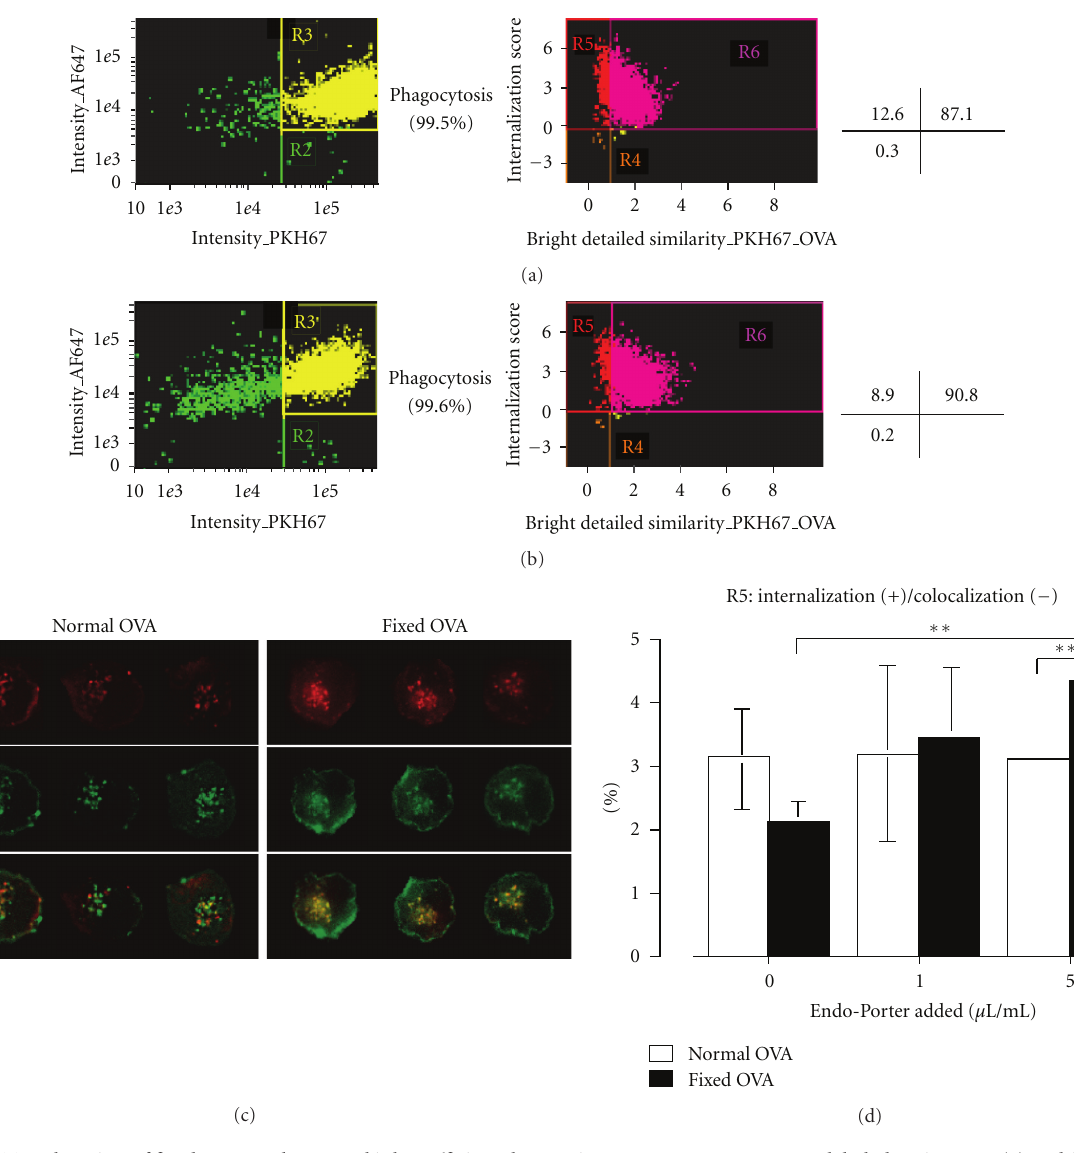
Figure 4: Translocation of fixed-OVA to the cytosol is less e ffi cient than native OVA. 0.5mg/mL AF647-labeled native OVA (a) and fixed OVA (b) were pulsed onto PKH67-labeled DC2.4 cells for 5minutes, washed, and subjected to ImageStream analysis. The relative frequency of cells in R5 of native and fixed OVA, thus, internalization (+)/colocalization ( − ), was 12.6% and 8.9%, respectively. (c) AF647-labeled native or fixed-OVA was pulsed onto PKH67-labeled DC2.4 cells for 5minutes, washed and subjected to fluorescence microscopy analysis. (d) The same experiments were done as in (a), except that DC2.4 cells were treated with or without Endo-Porter as indicated. The percentage of cells in R5 of native and fixed-OVA were plotted as a bar graph. Note: DC2.4 cells used in ((a)–(c)) were pretreated with 10 μ M MG115 15 minutes prior to and during incubation with OVA in order to prevent proteasome activity. Data are mean ± SD of two separate experiments. ∗∗ P < 0 .